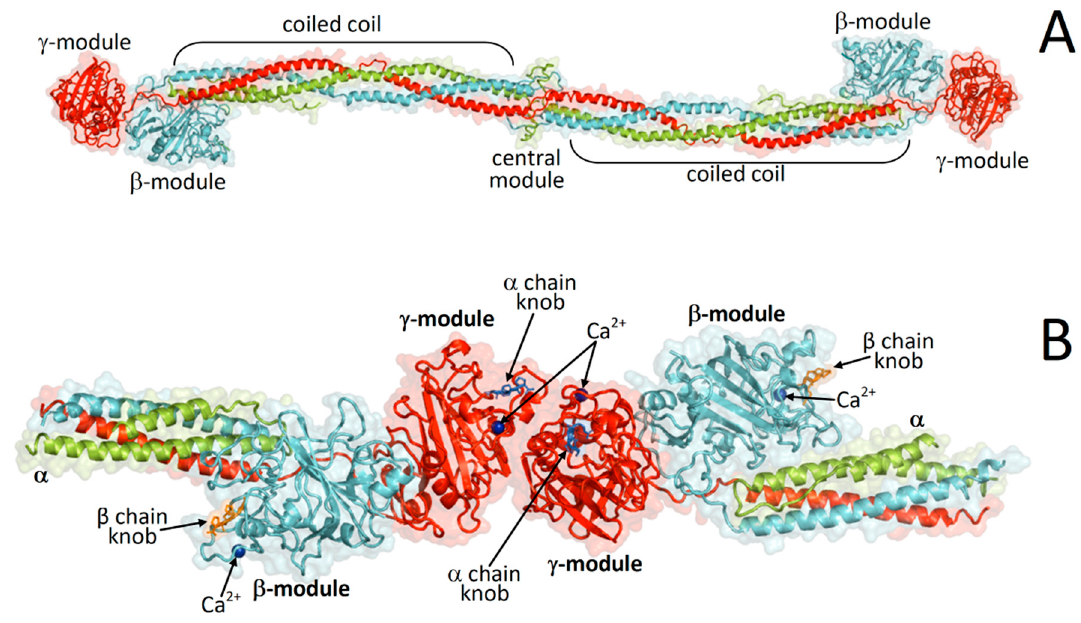
Figure Figure 1. Structures of the hexameric fibrinogen (A α , B β , γ ) 2 and fragment double-D. ( A ) Crystal structure of fibrinogen [1]; ( B ) crystal structure of fragment double-D from human fibrin [2].